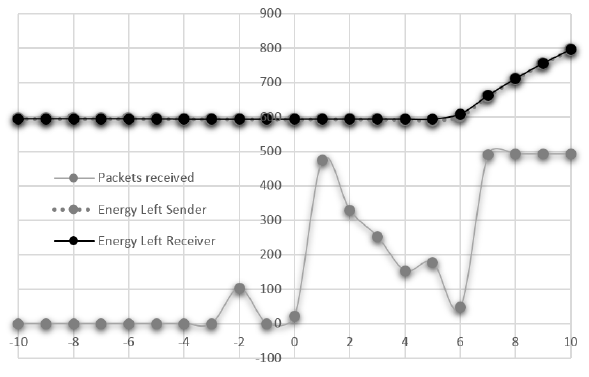
Figure 8. Energy left and received packets vs the transmission power in Scenario 1a .